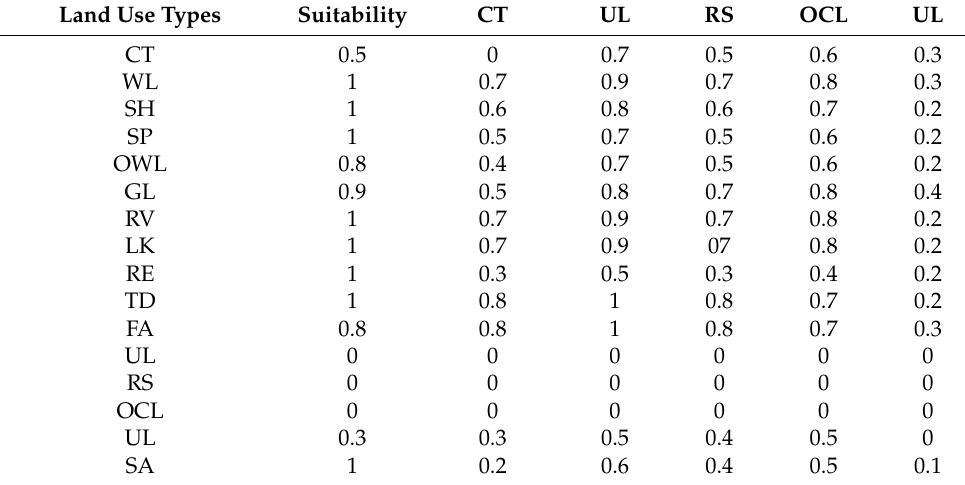
Table 3. Habitat suitability and sensitivity of each land use